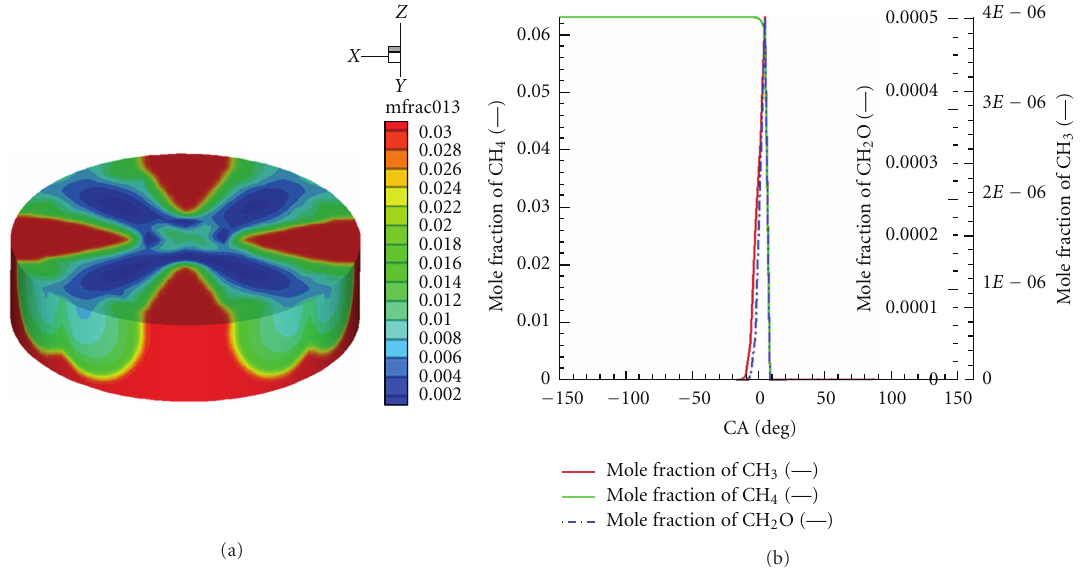
Figure 5: (a) Predicted methane mass fraction versus combustion duration and (b) mole fraction of methane, CH 3 , and CH 2 O